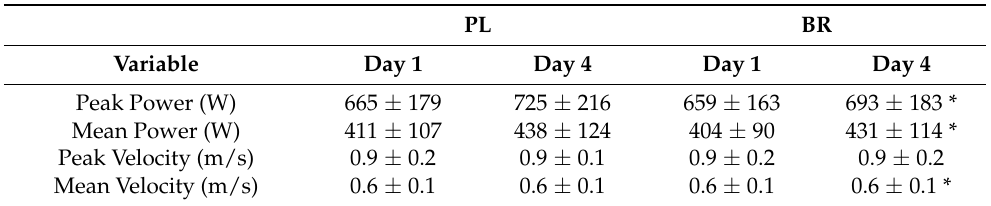
Table 8. Performance outcomes during a bench press exercise protocol for determination of power and velocity following acute and multiday nitrate supplementation.